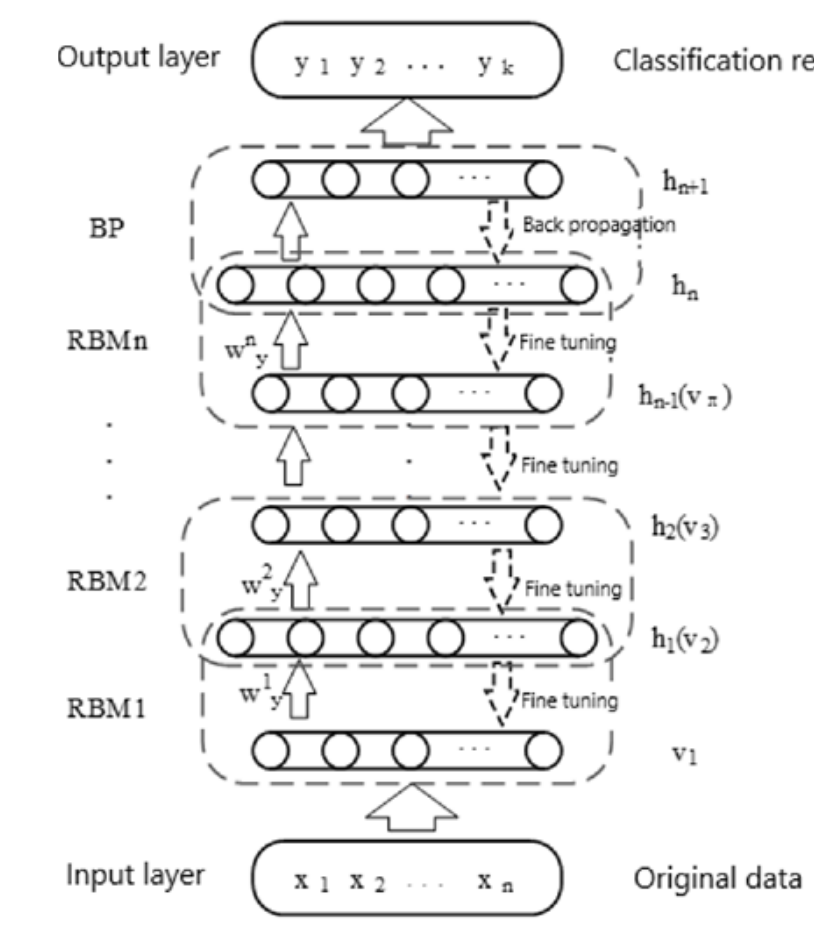
Figure 7. DBN model.